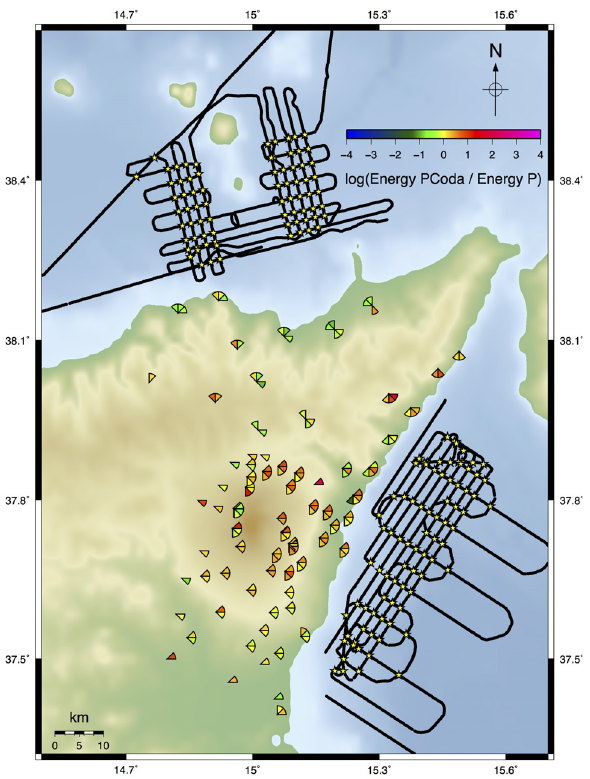
Figure A1. Energy ratio for P-phase with travel path lengths less than 40 km to eliminate a potential PmP-phase contamination. Each pie wedge uses at least 5 values for averaging. Green respec- tively blue colors symbolize a low ratio, yellow respectively red col- ors symbolize a high ratio values.